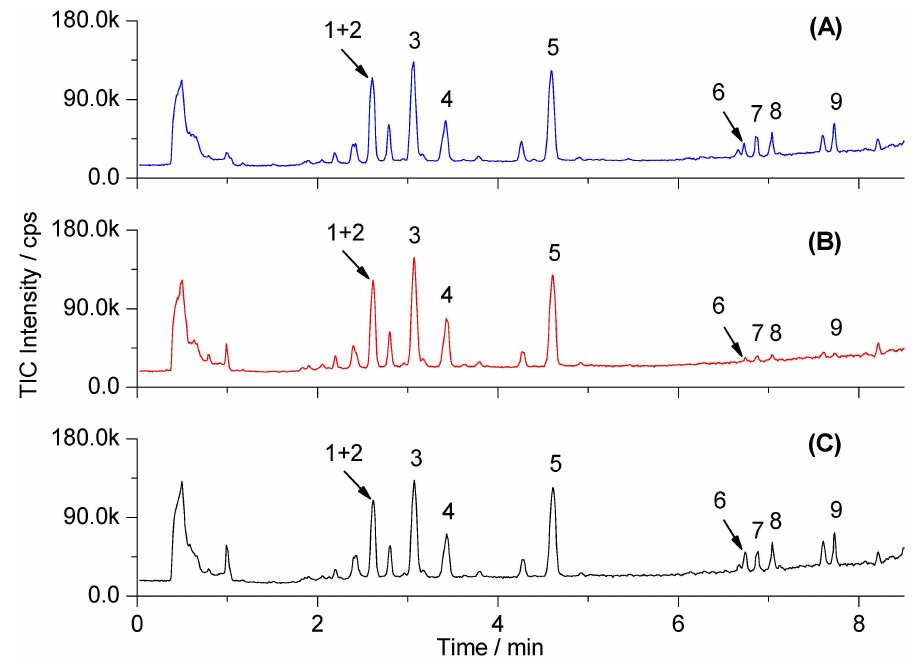
Figure 2. Representative UPLC-TOF-MS total ion chromatograms (TICs) of serum samples from control ( A ); model ( B ); and YCHT treated rats ( C ). Peak numbers of the identified metabolites are consistent with those in Tables 2 and 3.